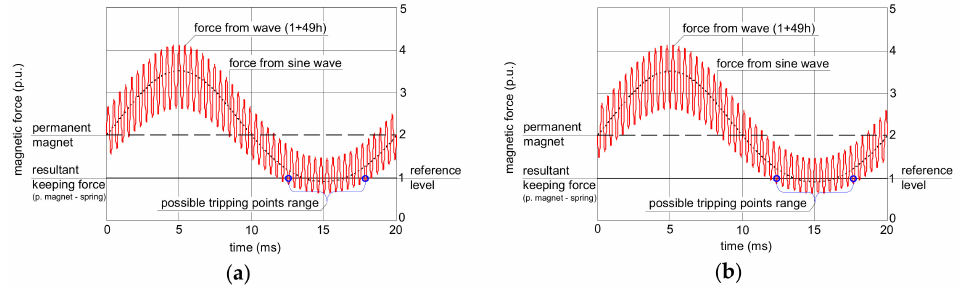
Figure 6. Interaction between forces in the electromechanical relay of the RCD for earth fault current waveforms comprising the fundamental and 50% of the 49 th harmonic. The phase angle of the 49 th harmonic: ( a ) 0 ◦ ; ( b ) 180 ◦